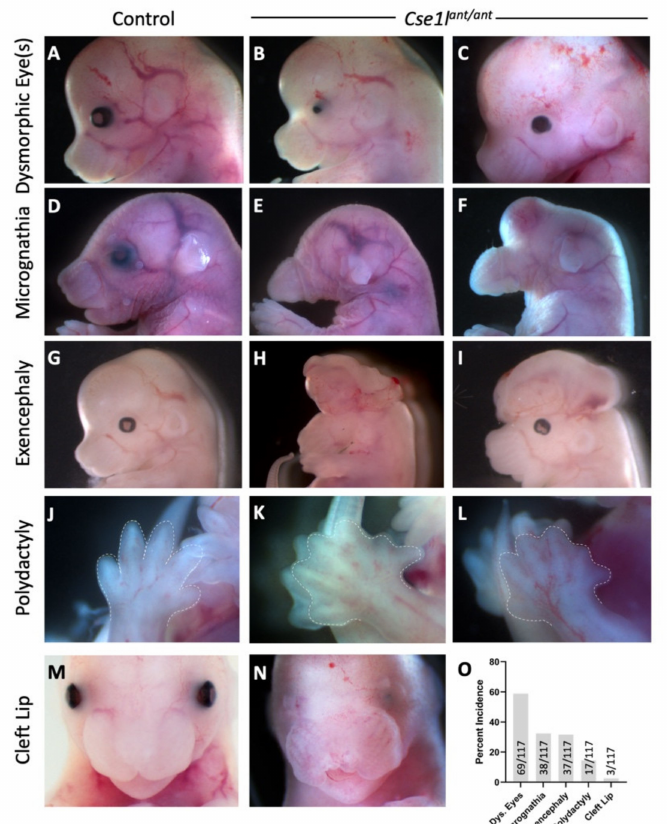
Figure 1. Cse1l ant/ant mutants display variable, incompletely penetrant phenotypes. ( A , D , G , J , M ) Control animals. ( B , C , E , F , H , I , K , L , N ) Cse1l ant/ant mutants display a range of dysmorphic eye fea- tures, ( B , C ) micrognathia and agnathia, ( E , F ) exencephaly, ( H , I ) polydactyly ( K , L ), and cleft lip ( N ); ( O ) Incidence of phenotypes over 117 mutants